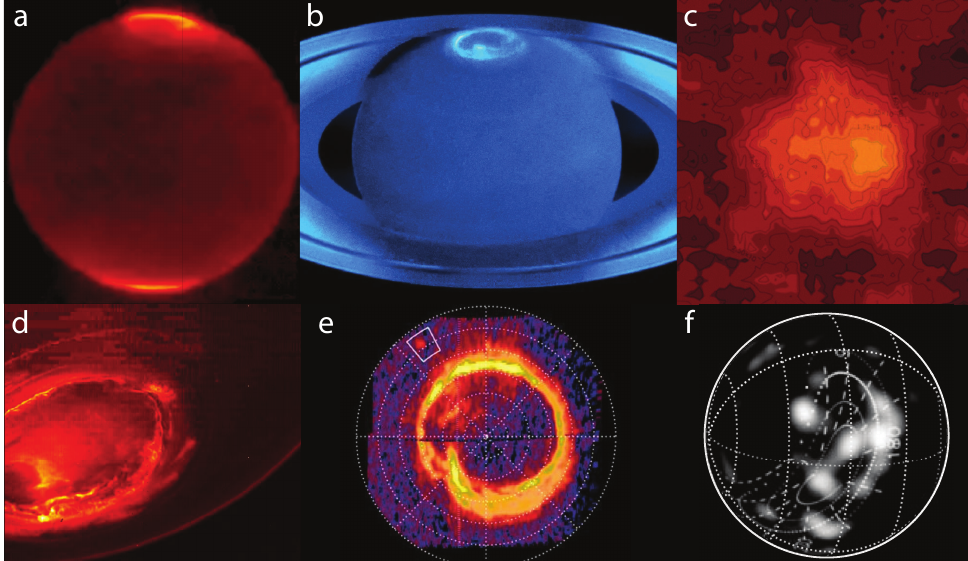
Figure 1. Upper-atmospheric emissions of Giant Planets. Earth-based telescope observations are shown in ( a – c ) while spacecraft observations taken near each planet are shown in ( d – f ). ( a ) IR view of Jupiter at 3.4 µ m, capturing emissions from the major upper-atmospheric ion H + image was taken by NSFCam on the NASA Infrared Telescope Facility (IRTF) [11]. ( b ) Saturn in UV, capturing emissions from upper-atmospheric hydrogen, taken by the Hubble Space Telescope (HST) in 2018; additional credits NASA/ESA, NASA and L. Lamy (Observatoire de Paris). ( c ) Uranus